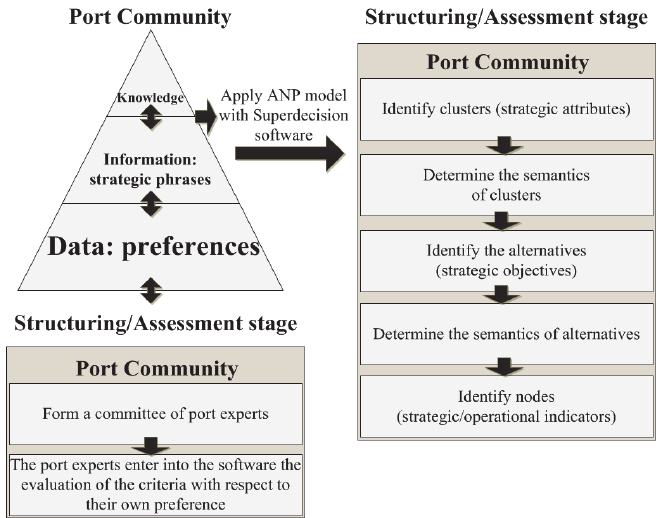
Fig. 3. Conceptual PORTGD model in the technological and risk context. Based (Kannan et al.,